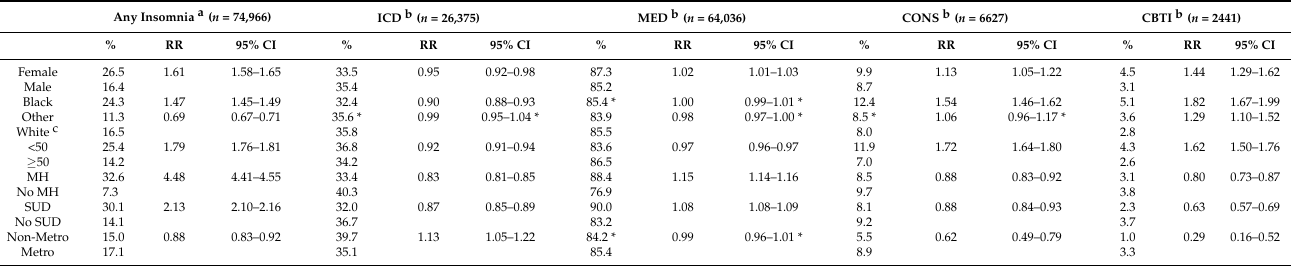
Table 3. Prevalence and relative risk of veterans with any insomnia and individual insomnia